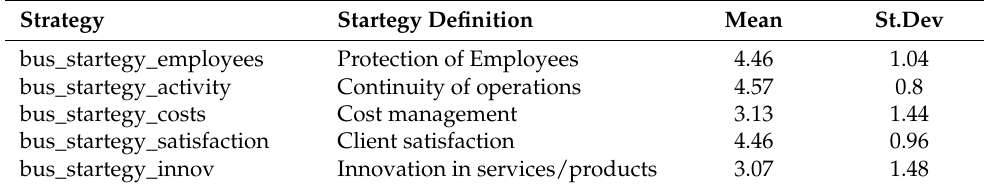
Table 11. Management